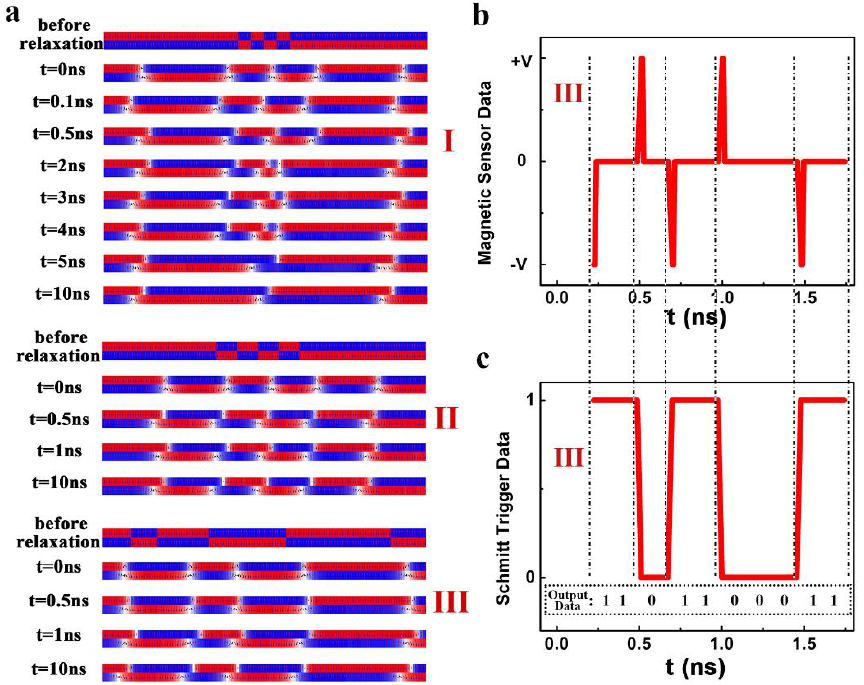
Figure 9. ( a ) The DW structure of the SAF racetrack at a different time with different initial intervals of the domain, ( b ) the output of the magnetic sensor and ( c ) the related digital signals for the case III in Figure 6a. The magnetic parameters including J ex , D , K U , and K L were fixed as − 0.25 mJ / m 2 , 0.75 mJ / m 2 , 6 × 10 5 J / m 3 , and 2.5 × 10 5 J / m 3 , respectively.